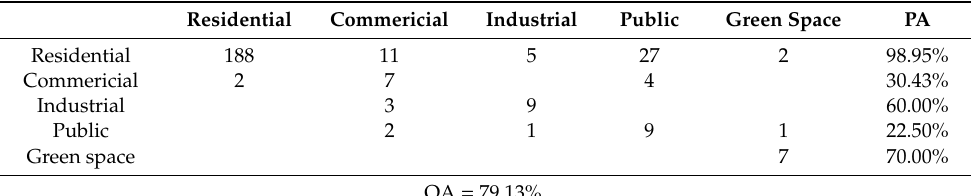
Table 4. Confusion matrix for the test samples with street feature participation.